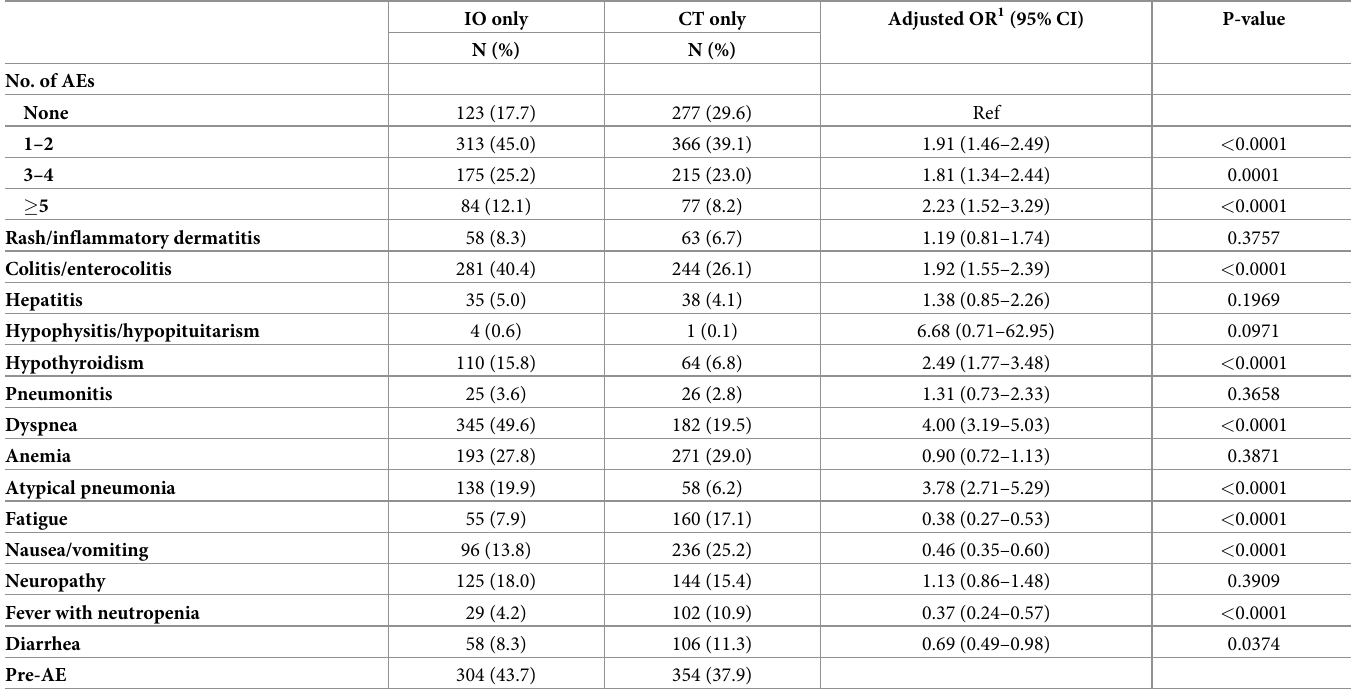
Table 5. AE occurrence by 2L